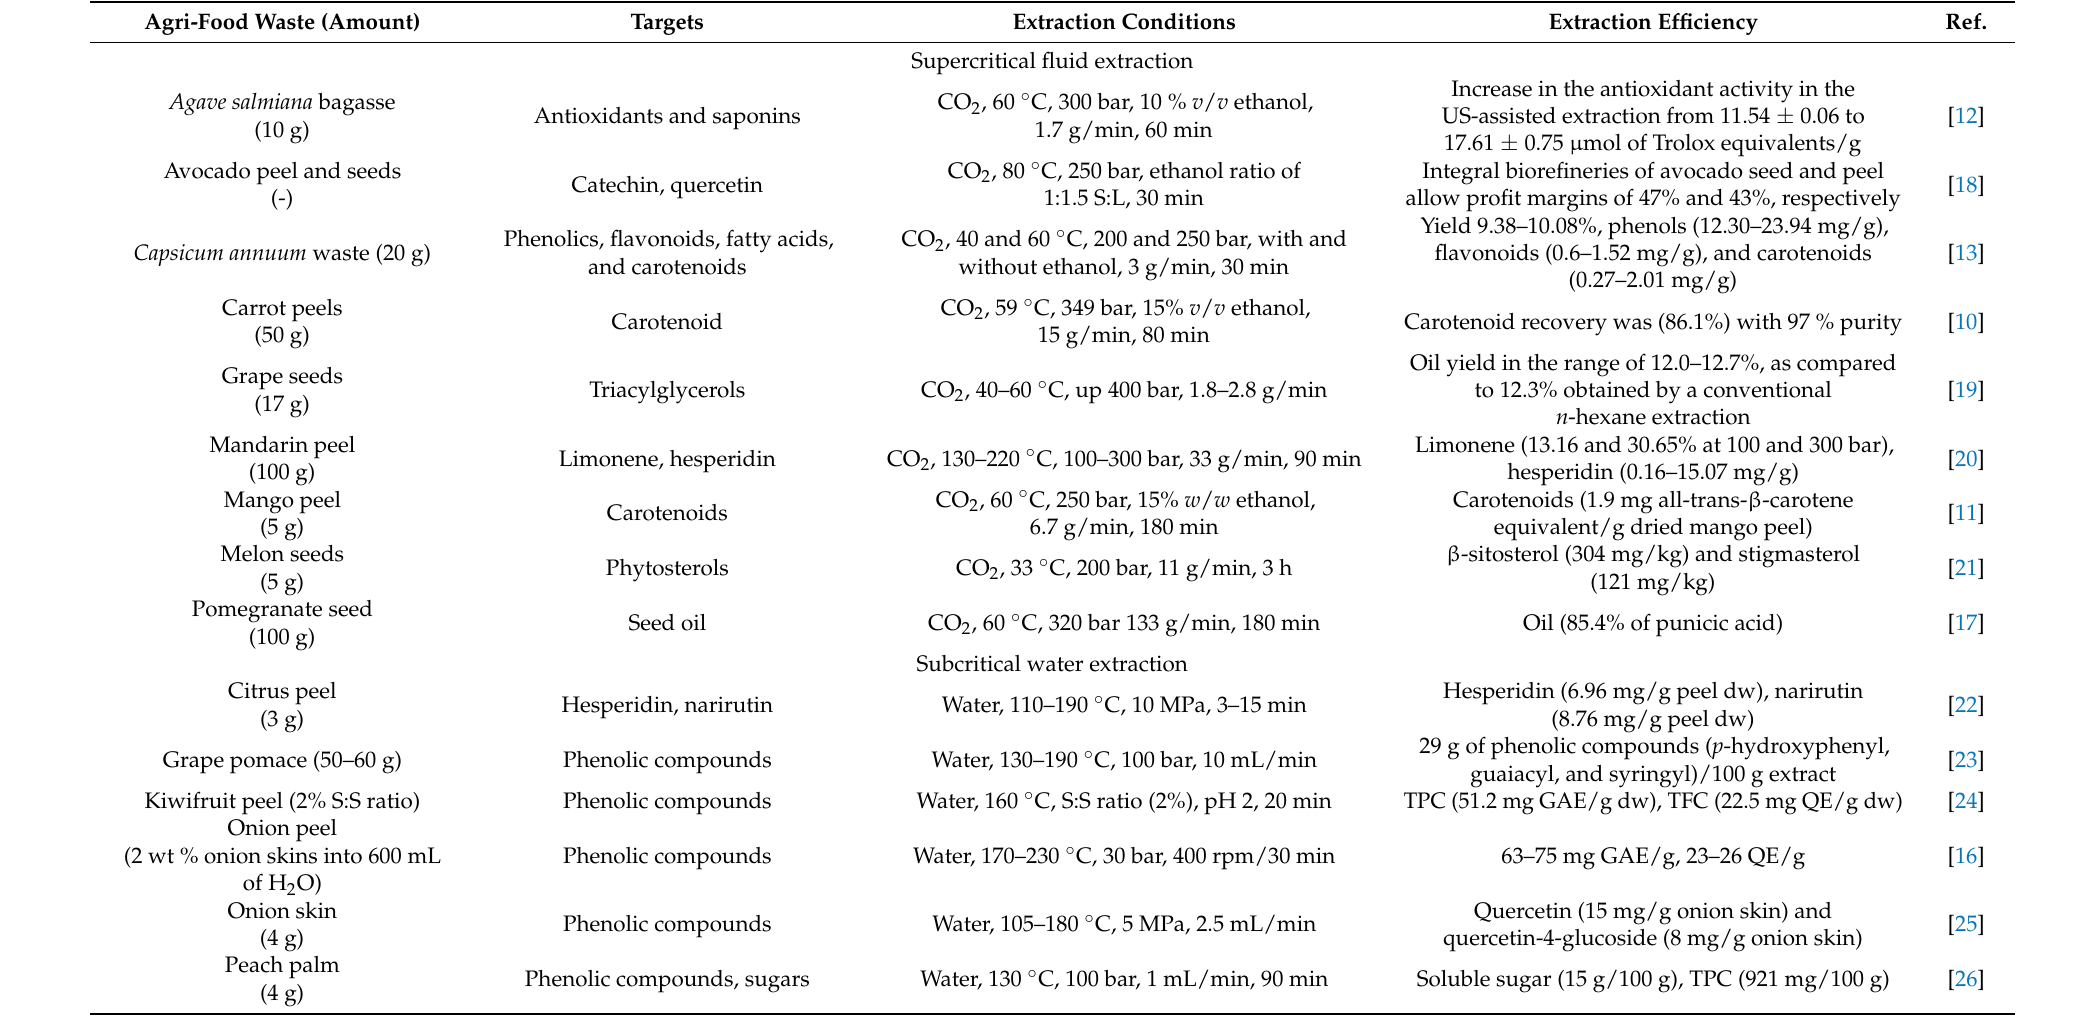
Table 1. Extraction techniques for bioactive recovery from agri-food